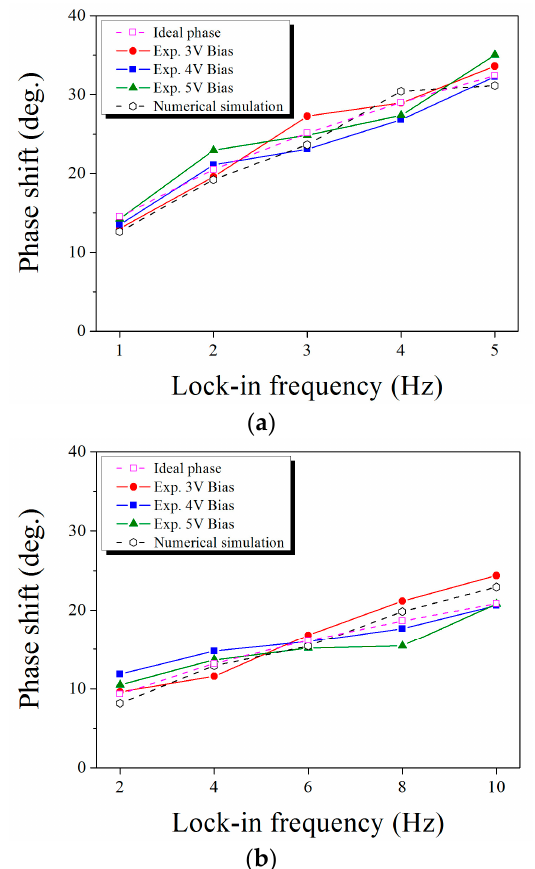
Figure 9. Phase shift of SSHSCs for different lock-in frequency and bias voltage: ( a ) two-layer SSHSC; ( b ) three-layer SSHSC.